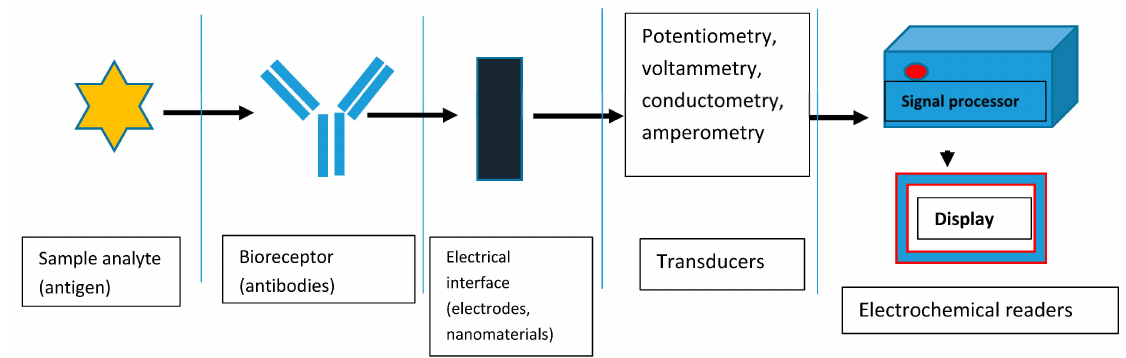
Figure 1. Basic components of a typical EC